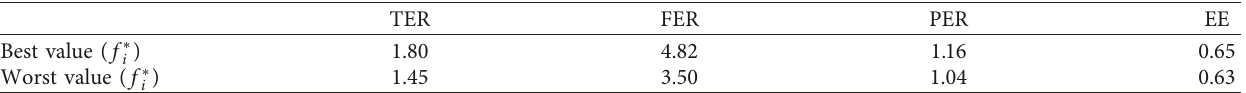
Table 13: Best and worst values of criteria.